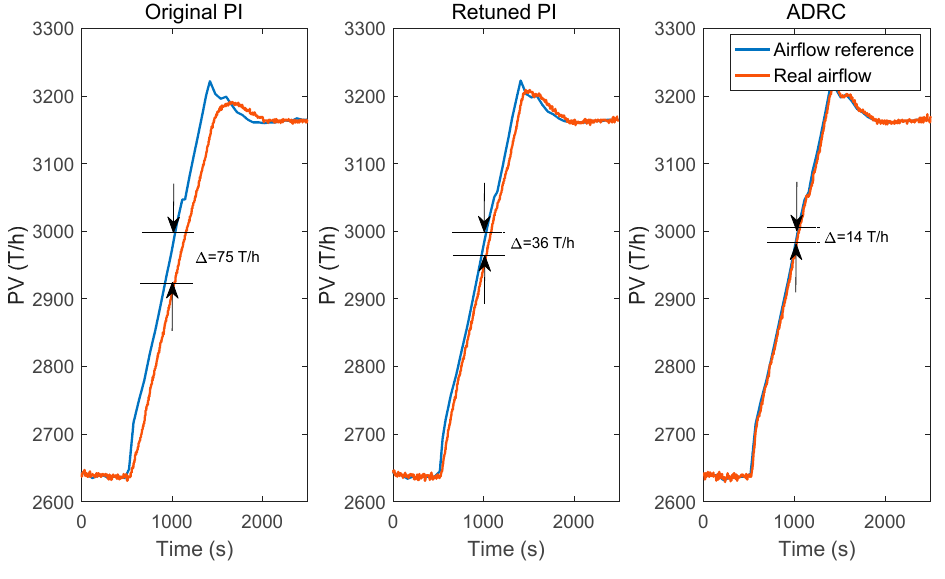
Figure 10. Reference tracking under varying loads. Table 3. Control performance comparison in the total air control experiments under constant and varying load